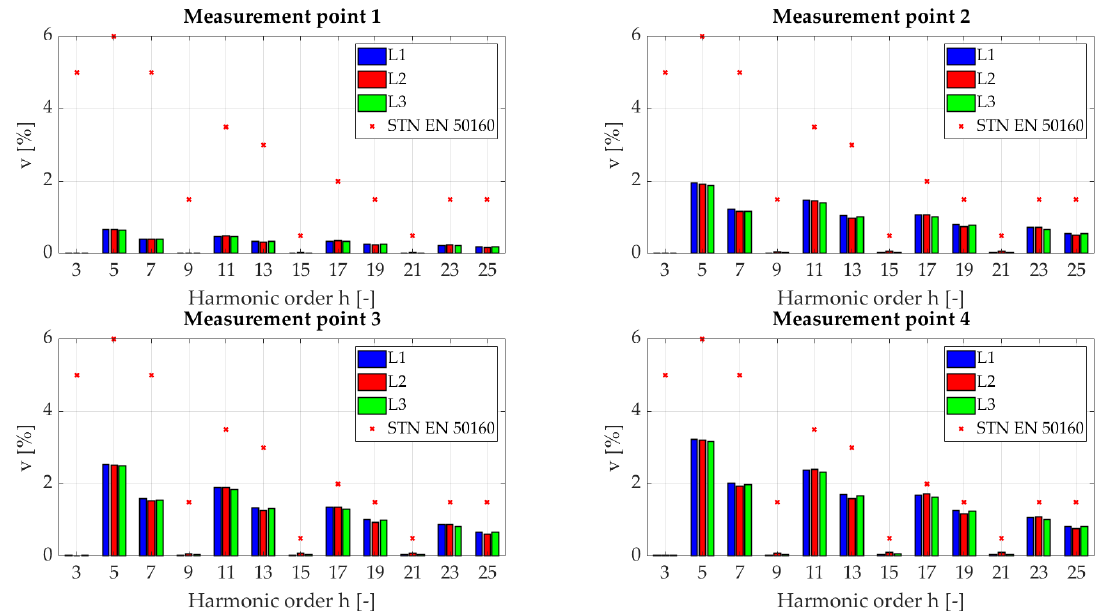
Figure 36. Voltage harmonic spectrum at the measurement points.